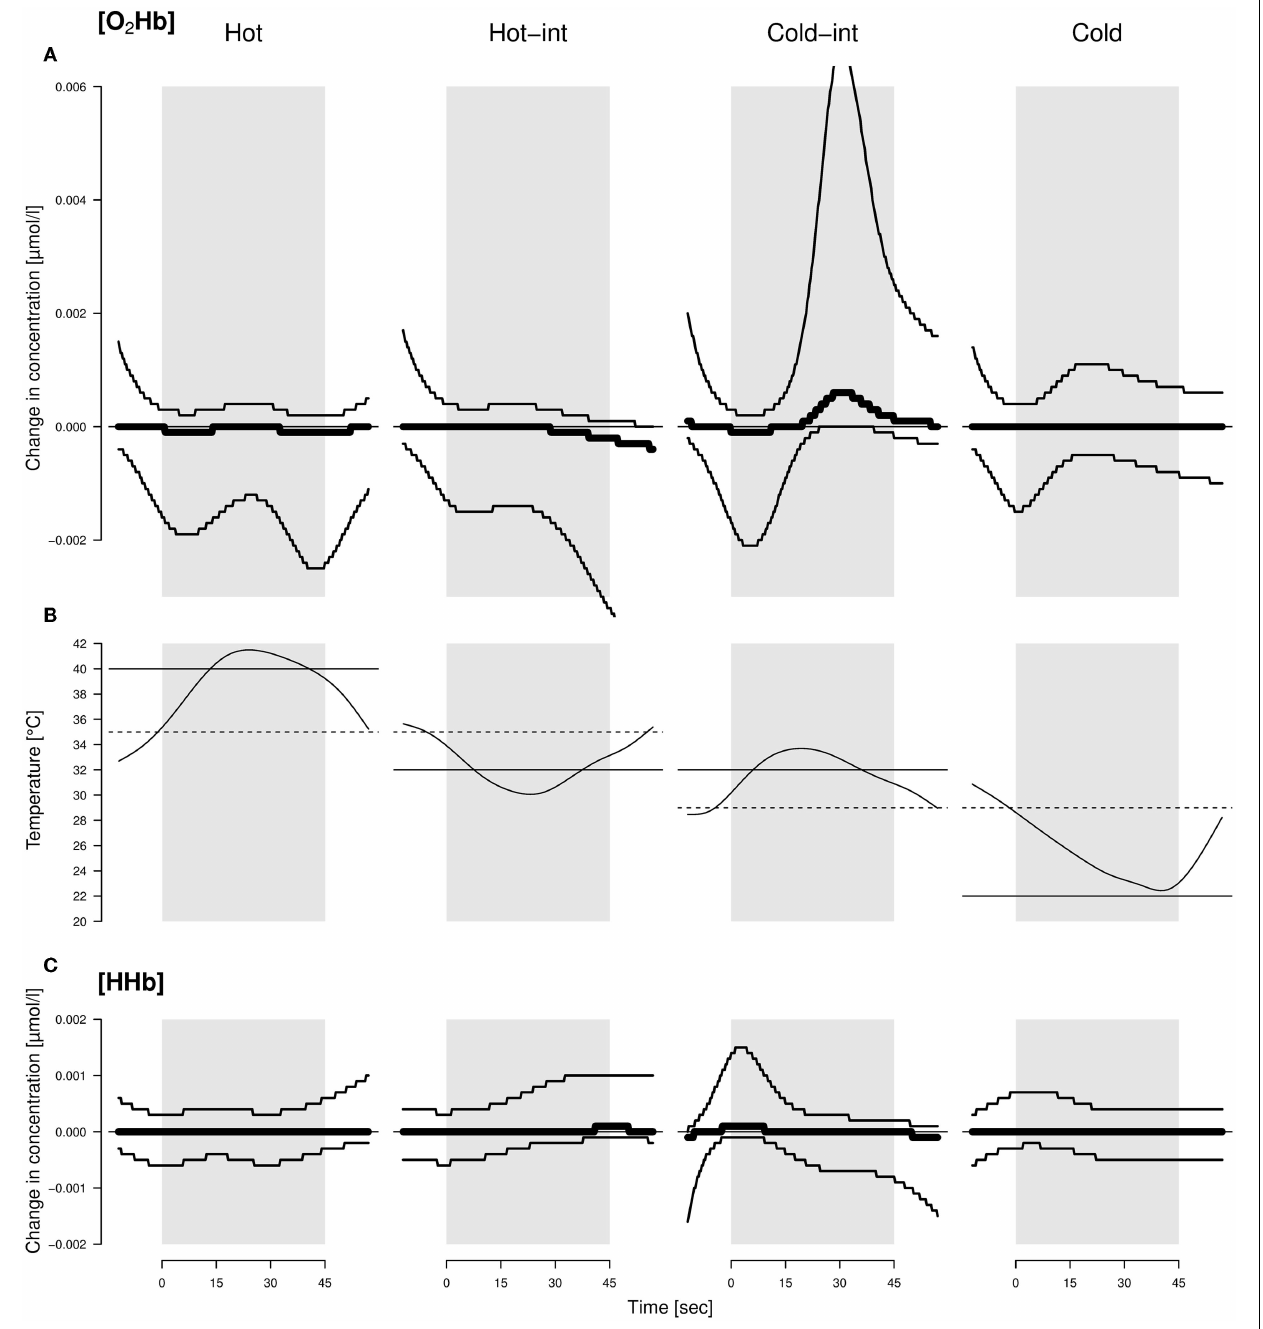
lines: 95% confidence intervals. See text for further information on the models. The best model did not include housing condition; hence, the displayed pattern was similar for both housing conditions. The average temperature profile per valence is displayed by the curves in the middle. Solid line: designated temperature for the stimulus; dotted line: designated temperature for the inter-stimulus